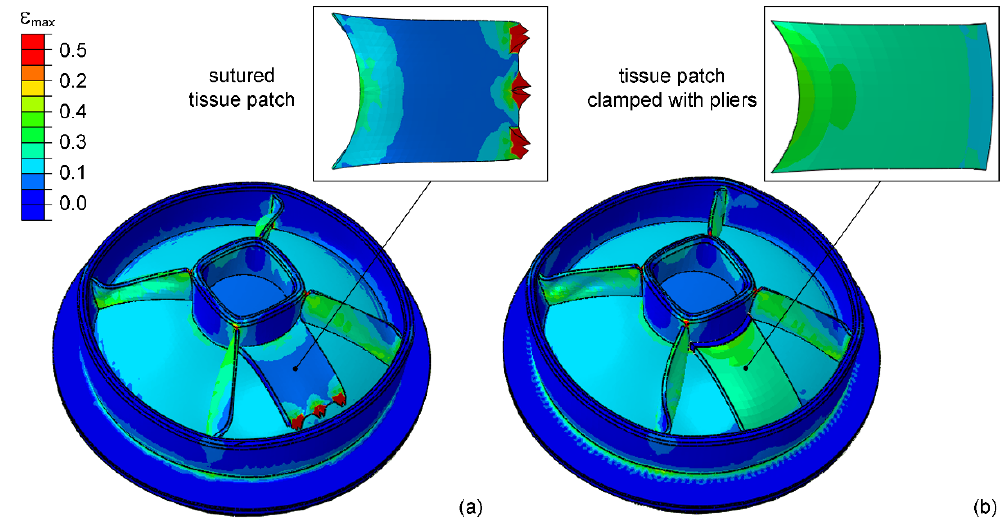
Figure 4. Contour of maximum principal strains ε max of the bioreactor membrane with clamped tissue patch by means of suture thread ( a ) and pliers ( b ).